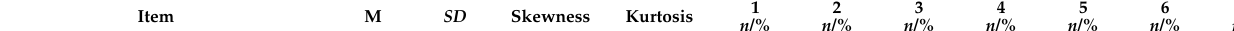
Table 1. Descriptive analysis of the SOC-13 items (frequencies, means, standard deviations, skewness and kurtosis). Item M Skewness